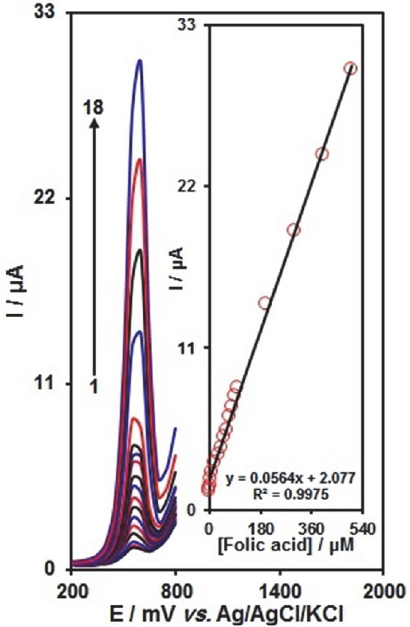
Fig. 7. DPVs of NFO/SPE in 0.1 M PBS (pH 7.0) containing differ- ent concentrations of folic acid. Numbers 1–18 correspond to 0.1, 0.5, 1.0, 5.0, 10.0, 20.0, 30.0, 40.0, 50.0, 60.0, 70.0, 80.0, 90.0, 100.0, 200.0, 300.0, 400.0 and 500.0 μM of folic acid. The inset shows the plot of the peak current as a function of the folic acid concentration in the range of 0.1–500.0